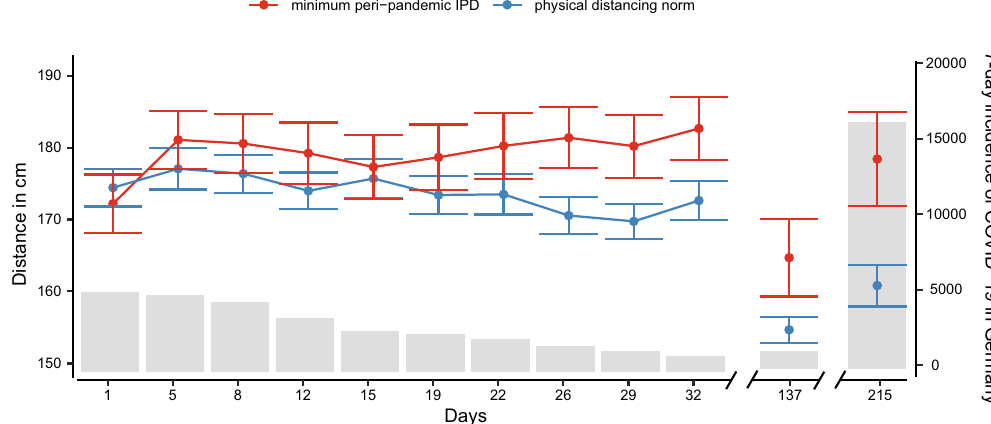
Figure 3. Physical distance norm and minimum interpersonal distance (IPD in cm) during the pandemic averaged across the silhouette gender (left y-axis), and 7-day incidence of COVID-19 cases (right y-axis) as a function of days since the first measurement (one week after the beginning of the first lockdown in Germany).